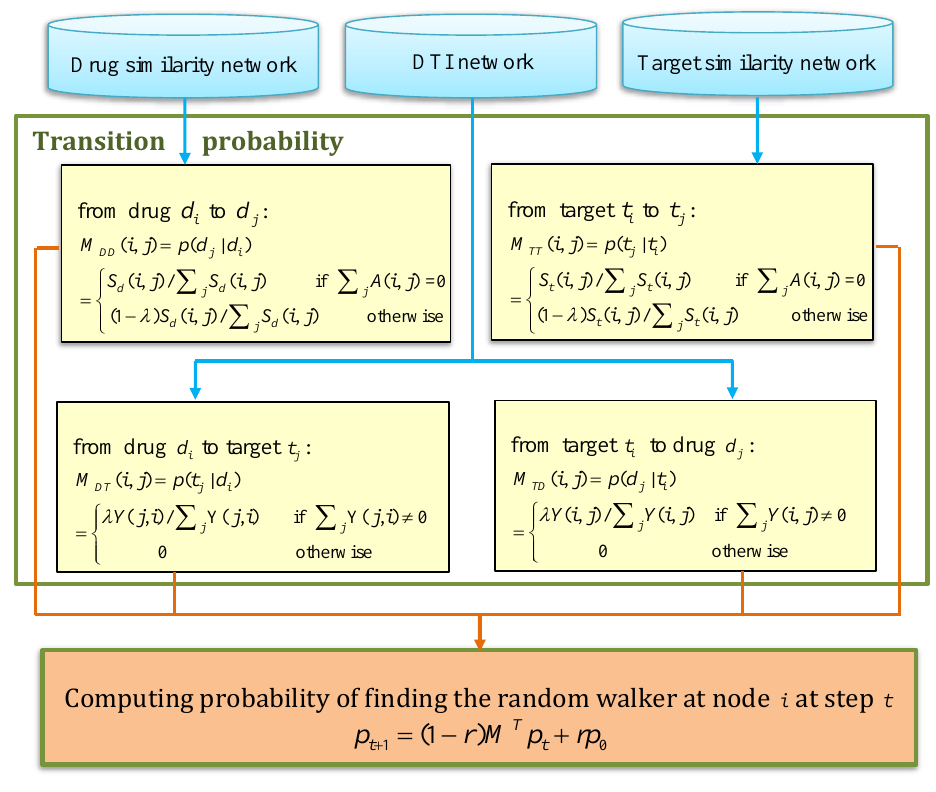
Figure 3. The flowchart of Network-based Random Walk with Restart on the Heterogeneous network